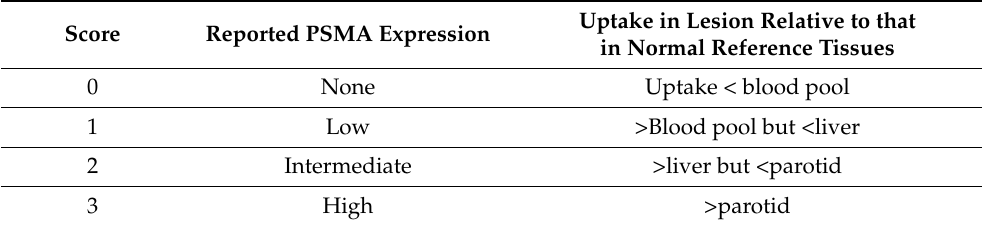
Table 8. miPSMA expression scoring system, equating likelihood of malignancy to ratios of activity in lesions to that in normal reference tissues